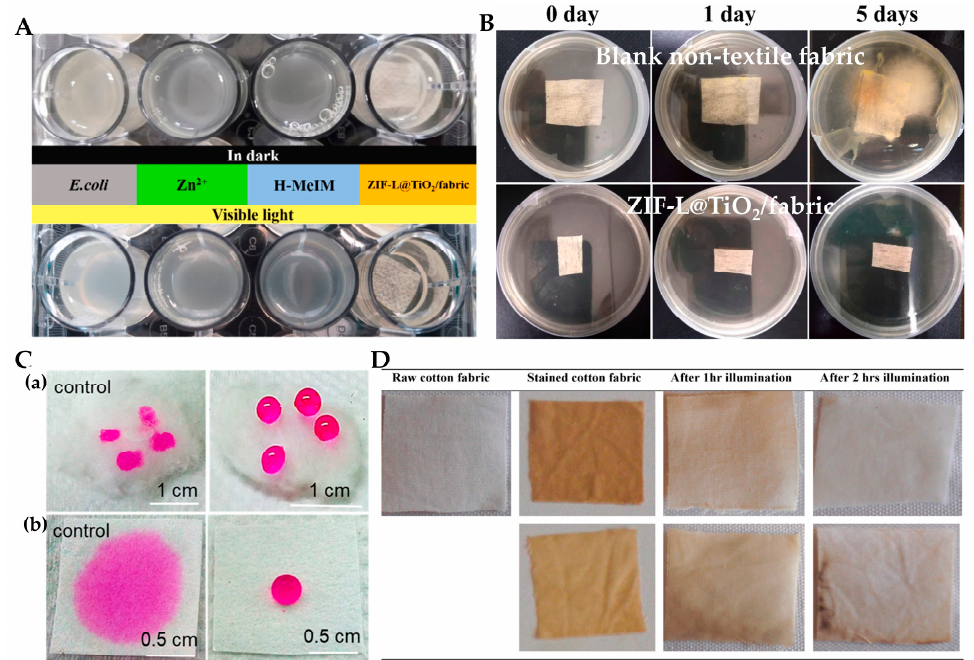
Figure 14. ( A ) Photographs of the antibacterial activity of Zn2+, H-MeIM and ZIF-L@TiO 2 /fabrics against E. coli ; ( B ) photographs of bacterial growth on blank nontextile fabric and ZIF-L@TiO 2 /fabric under natural light for 1–5 days at 37 °C [143]; ( C ) nonwetting behavior of modified cotton ( a ) and paper ( b ) surface [144] paper; ( D ) self-cleaning performance of 1% Cu (II)-doped TiO 2 calcined at 25 °C [145].